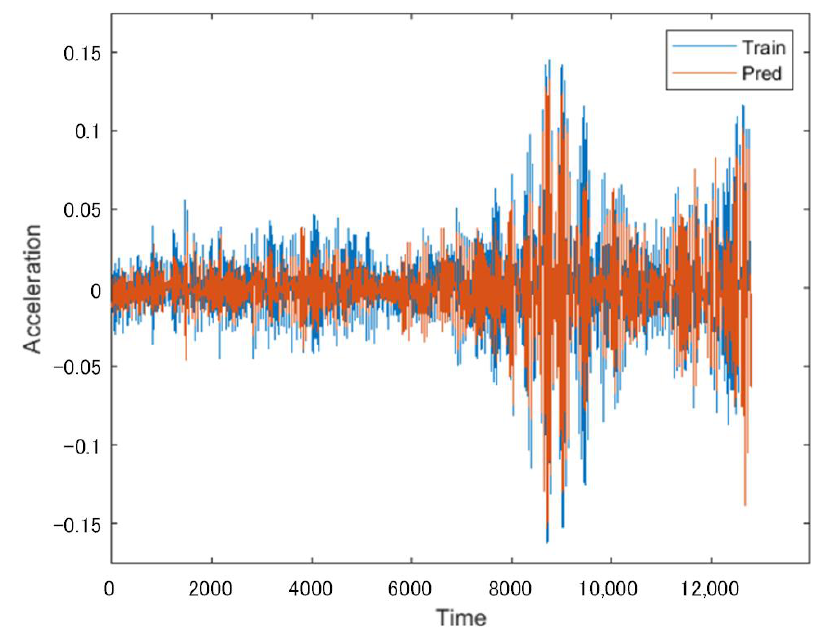
Figure 5. Training results from Channel 8.